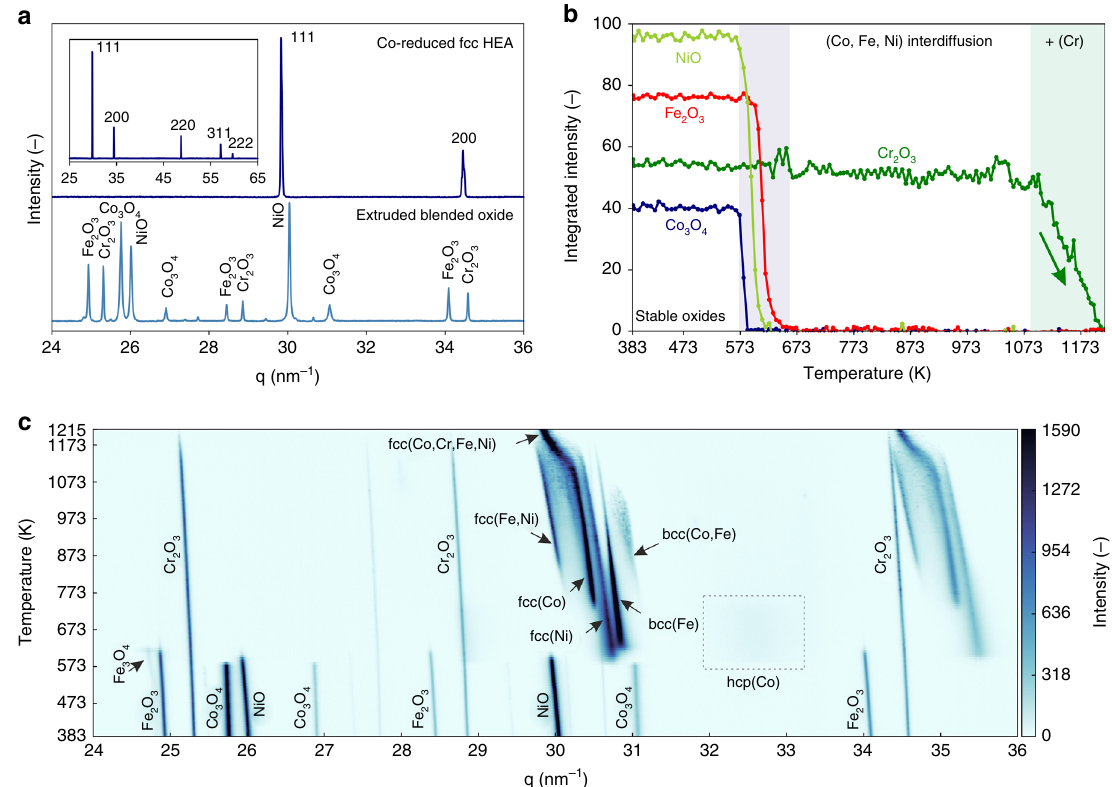
Fig. 2 Phase evolution upon co-reduction of 3D printed blended oxides by in-situ synchrotron XRD in H 2 . a XRD diffractograms of a 250 µ m diameter fi lament extruded from blended Co + Cr + Fe + NiO inks (bottom) and the inter-diffused fcc HEA fi lament after completion of the co-reduction 3 O 4 2 O 3 2 O 3 step (top). Inset: full data range of the fcc HEA alloy. b Evolution of the integrated peak intensities for Co 3 O 4 , Cr 2 O 3 , Fe 2 O 3 , and NiO, demonstrating sequential reduction forming Co, Ni, Fe between 573 and 637 K, followed by reduction of Cr 2 O 3 between 1073 and 1215 K. c 2D phase evolution plot (temperature vs. the scattering vector q, with diffraction peak intensity as color map) during in situ XRD upon heating and reduction in H 2 , illustrating